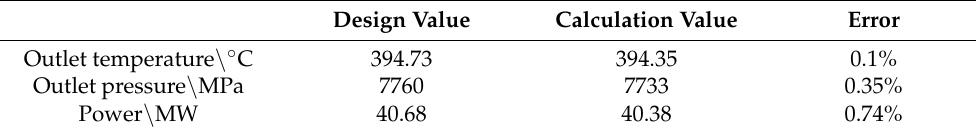
Table 4. Comparison of the turbine.